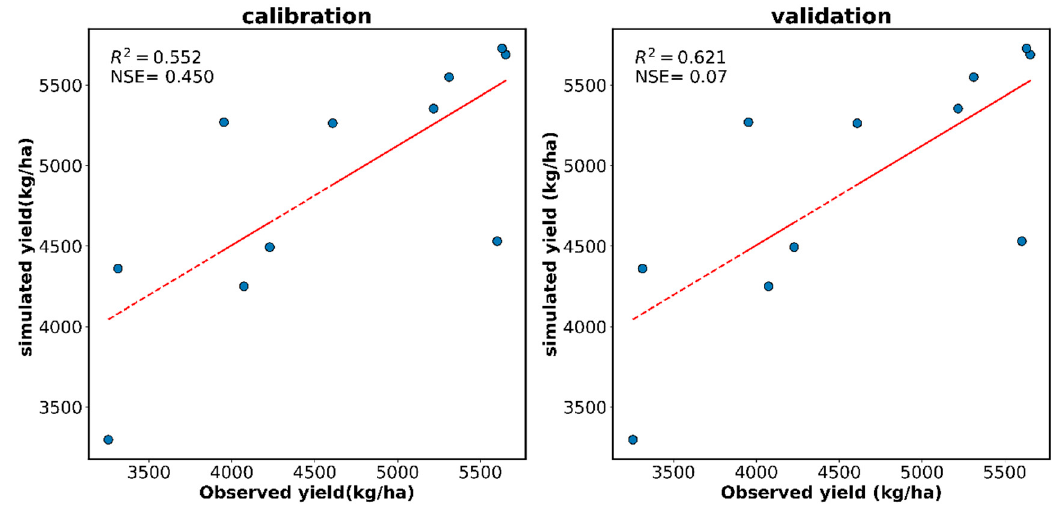
Figure 5. Comparison of observed vs. simulated annual soybean yield during model calibration and validation.